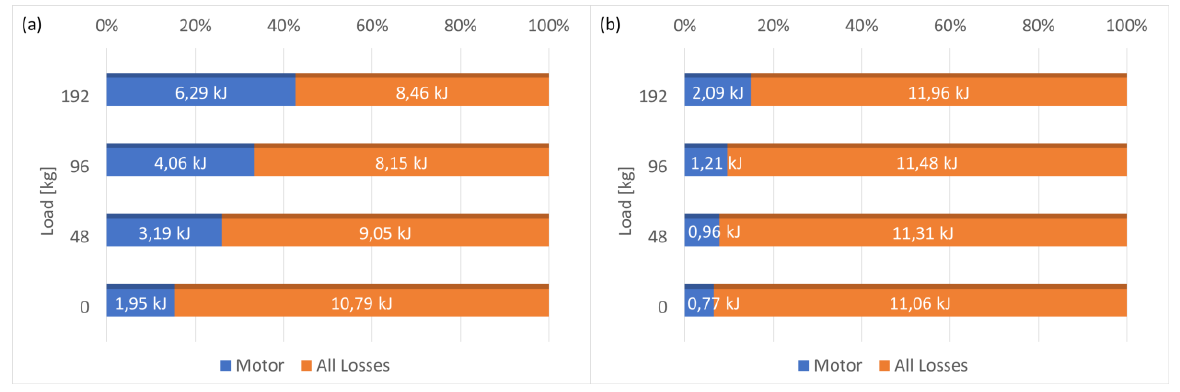
Figure 7. Energy consumption of constant components within an hour.